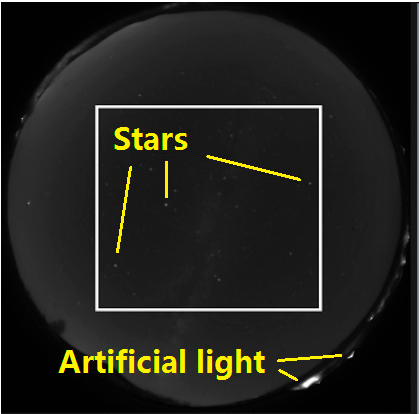
Figure 3. Detection area in a raw image. To avoid the disturbance of artificial light, a 512 × 512 square at the center was cropped for detection.